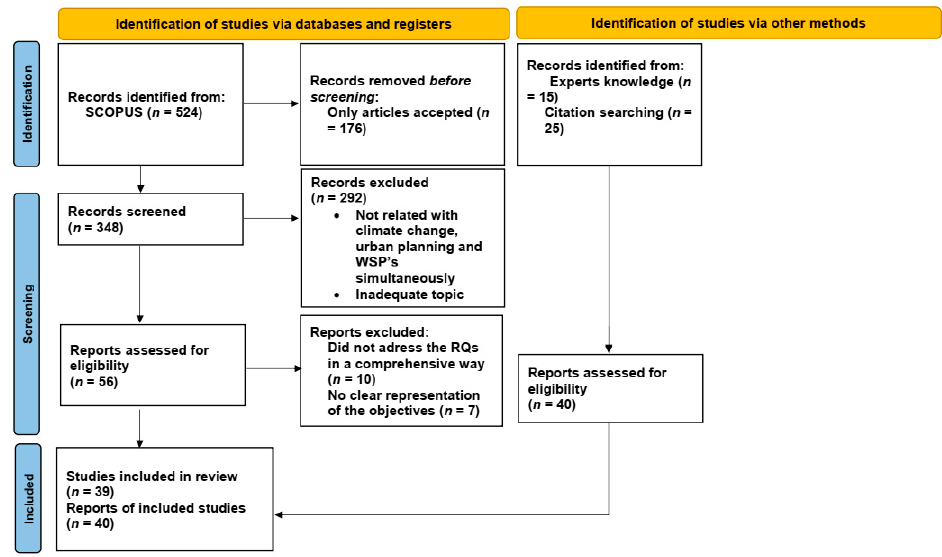
Figure 1. Methodological flow diagram summarising the steps to retrieve the articles